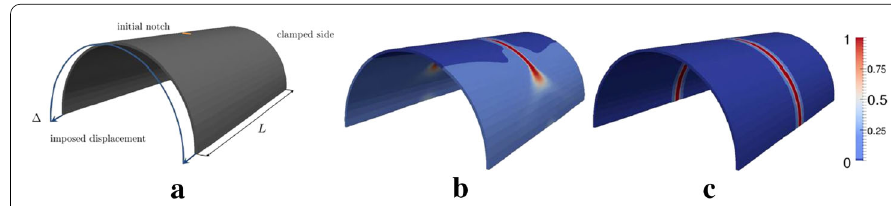
Fig. 7 Tensile test of a cylindrical shell. a Geometry and loading condition of the test; b crack propagation; c specimen failure (from